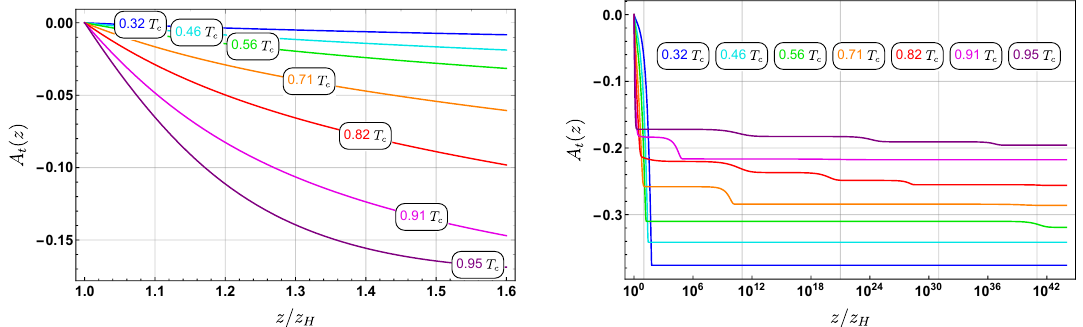
Figure 4 . The dynamics of A t with respect to z/z H inside the hairy black holes at different temperatures. Towards the singularity, A decreases monotonically with many alternations of t plateaus in the deep